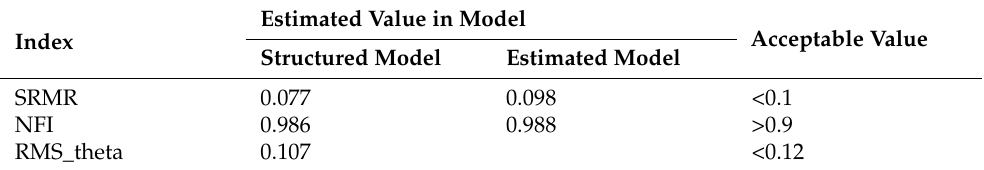
Table 4. The goodness-of-fit of the model.